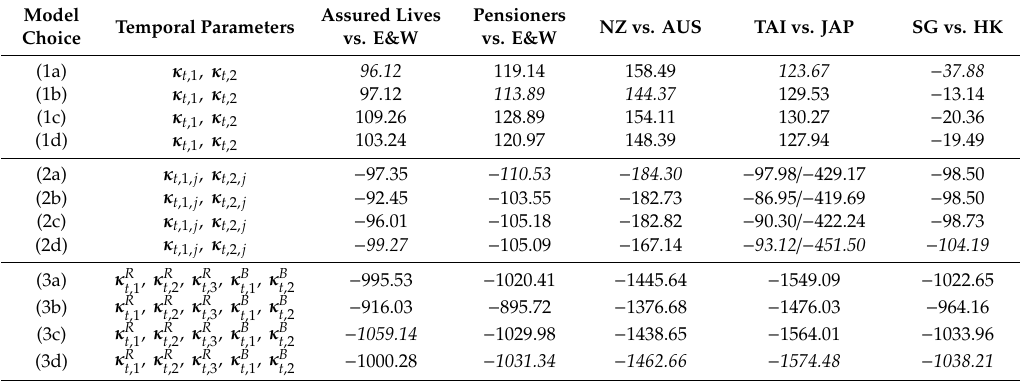
Table A2. BIC values of fitting various time series processes under di ff erent mortality projection models for di ff erent